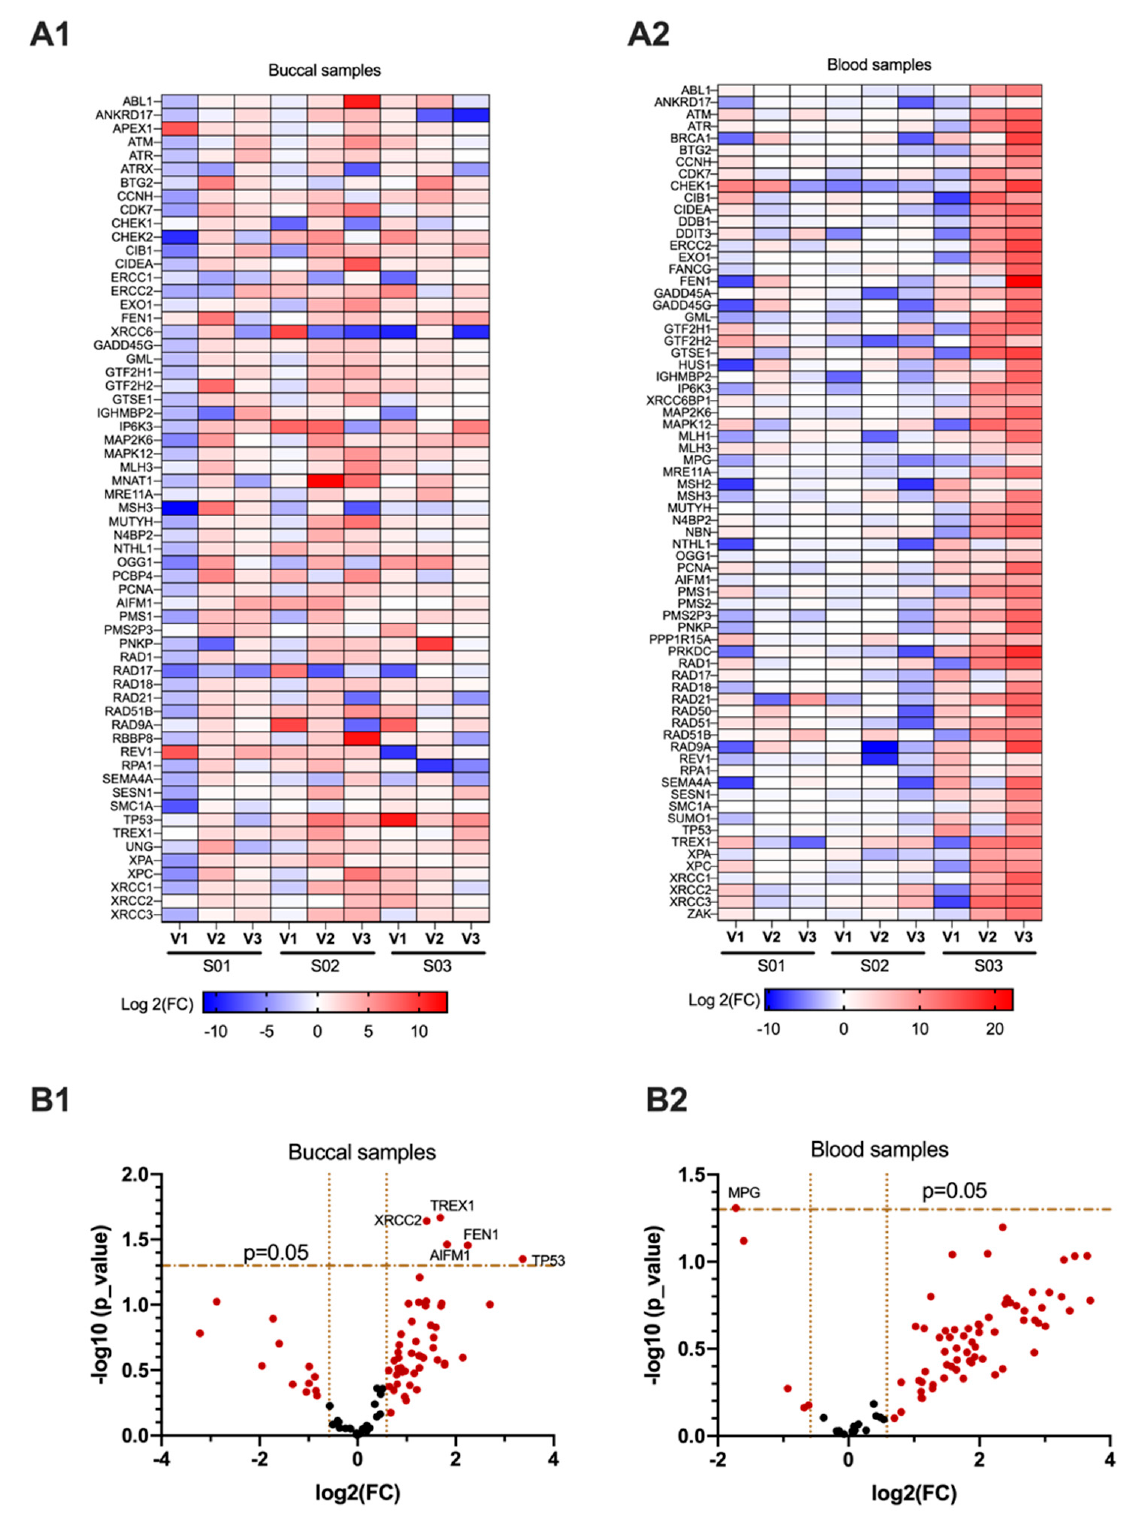
Figure 1. Differentially (1.5-fold change up or down) regulated genes in buccal and blood samples for three subjects across three visits. ( A1 , A2 ) Heat maps showing log2 fold change (FC) after vaping; almost all DNA damage genes were differentially upregulated in blood samples of subject 3 ( A2 ), compared to subjects 1 and 2. ( B1 , B2 ) Volcano plots showing the significantly ( p < 0.05) expressed genes after e-cig exposure. Five DNA damage genes including tumor suppressor TP53 were significantly upregulated by mean of all buccal samples ( B1 ), while N-methylpurine DNA glycosylase ( MPG ), was the only gene that significantly downregulated by mean of all blood samples ( B2 ).